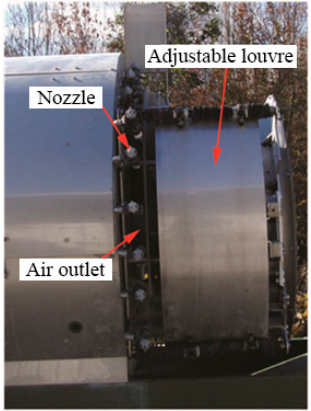
Figure 8. Variable air supply by adjusting air outlet area